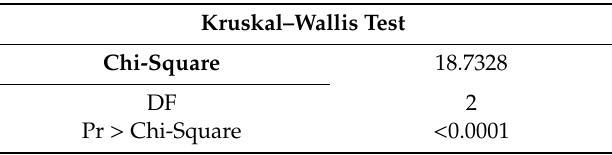
Table 6. Kruskal–Wallis Test.